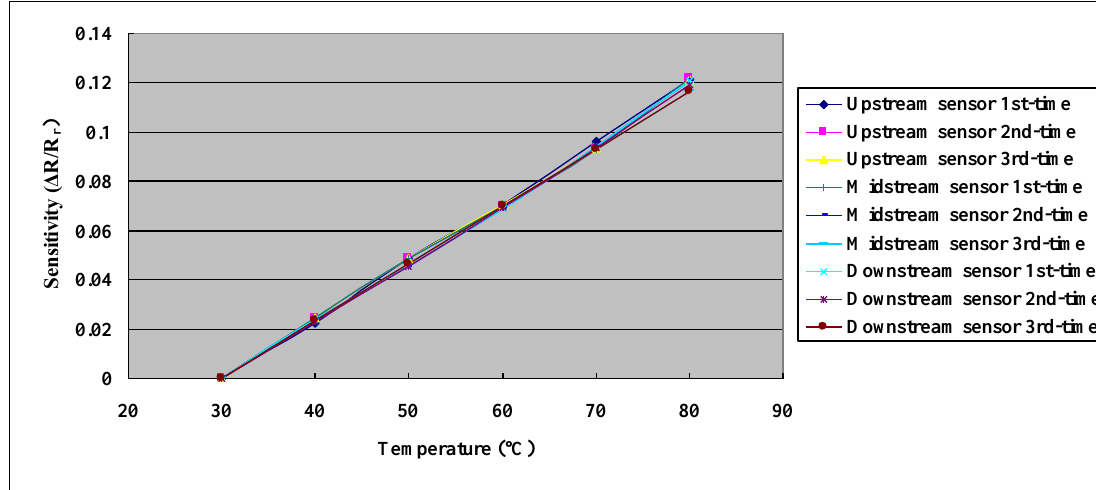
Figure 8. Calibration curves of the micro temperature sensors.